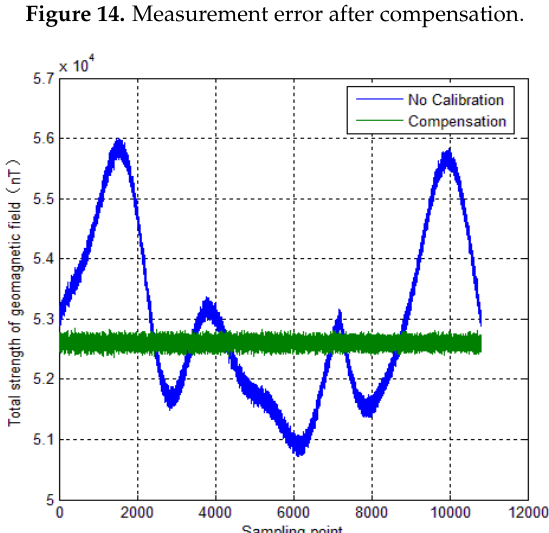
Figure 16. Trajectory of a spinning projectile. Figure 17. The full attitude of projectile.